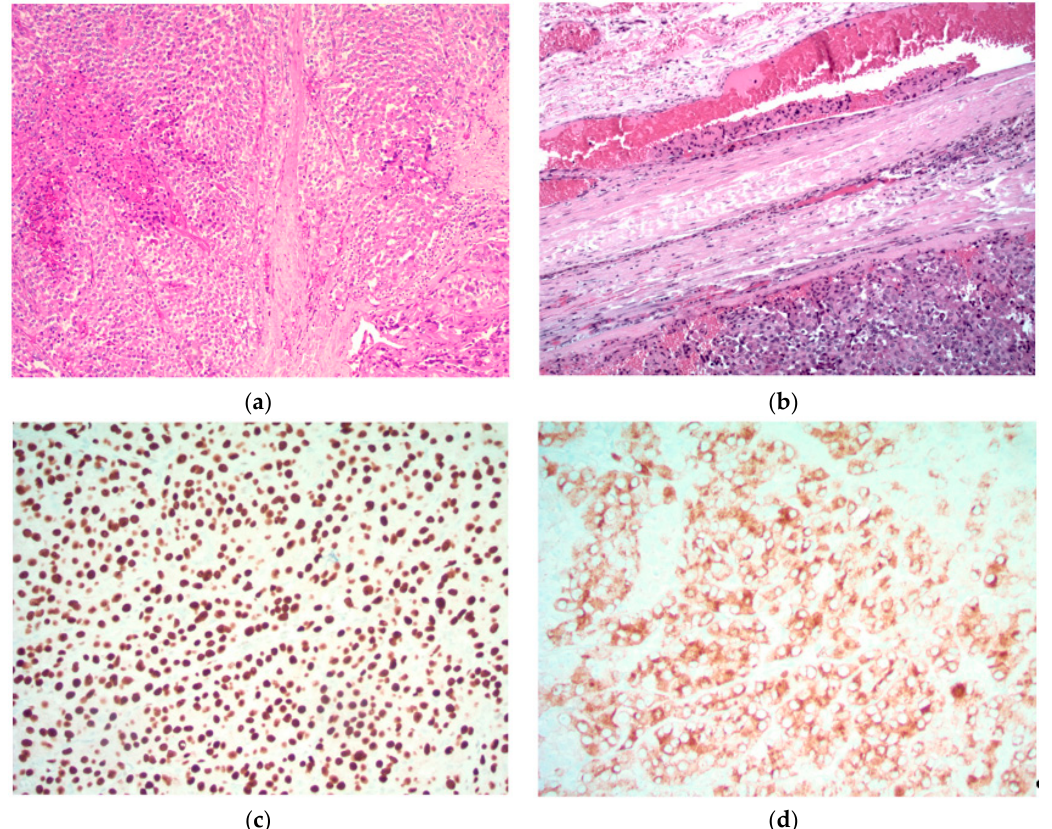
Figure 1. Parathyroid carcinoma is characterized by sheets of parathyroid cells with fibrosis and focal necrosis (top left). The diagnosis is confirmed by the identification of unequivocal vascular invasion defined as tumor cells within vascular channels associated with fibrin (top right). The tumor cells exhibit nuclear positivity for GATA3 (bottom left) and cytoplasmic positivity for chromogranin (bottom right) and parathyroid hormone (not shown), confirming parathyroid differentiation. Original magnification ( a ) × 120; ( b ) × 200; ( c ) and ( d ) × 400.